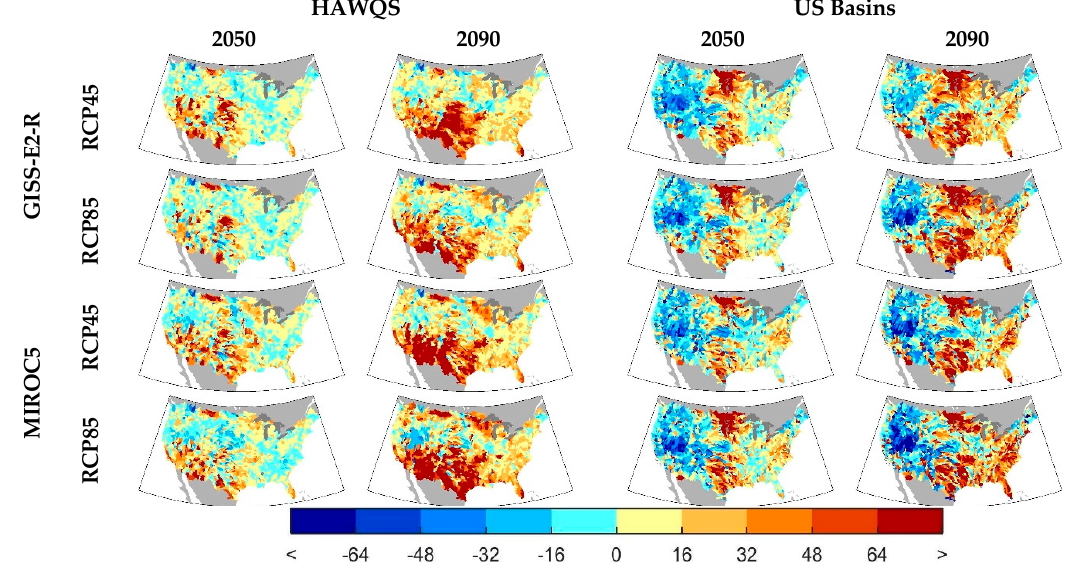
Figure 8. Percentage changes in mean ( left ) HAWQS and ( right ) US Basins nitrogen concentrations at the HUC ‐ 8 watershed scale for both the GISS ‐ E2 ‐ R and MIROC5 climate models, two emissions scenarios, and two eras.